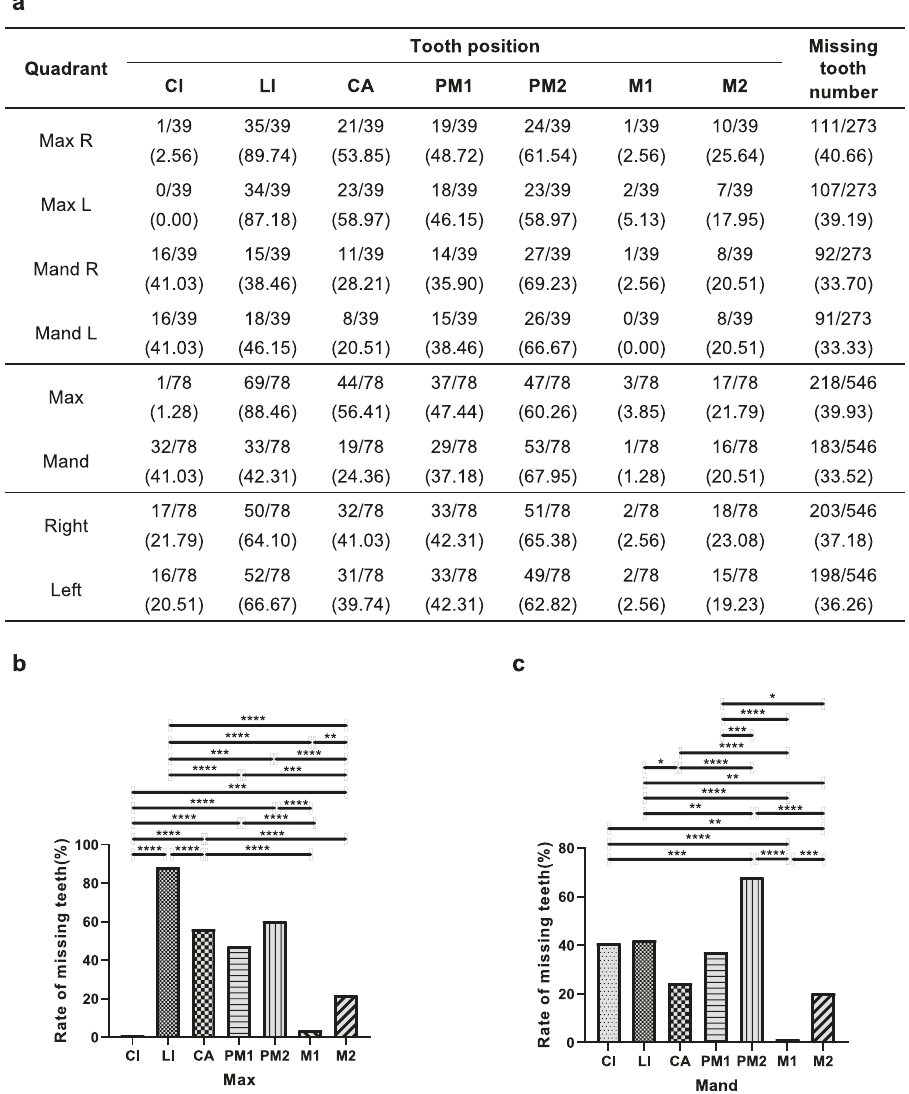
Fig. 3 Percentage of missing tooth positions at each maxillary and mandibular dentition in all reported tooth agenesis patients with LRP6 mutations ( n = 39). a Analysis of missing tooth number 39 tooth agenesis patients with LRP6 mutations at each tooth position of their permanent dentition (excluding the third molars). b , c Percentage of missing tooth positions at each maxillary and mandibular dentition in all tooth agenesis patients with LRP6 mutations ( n = 39). The numerator denotes the number of missing teeth and the denominator denotes the total number of teeth in each tooth position. The number in brackets denotes the rate of missing teeth. Max, maxillary; Mand, mandibular; CI, central incisor; LI, lateral incisor; CA, canine; PM1, fi rst premolar; PM2, second premolar; M1, fi rst molar; M2, second molar. Statistical signi fi cance: P values are: * P < 0.05, ** P < 0.01, *** P < 0.001, and **** P <